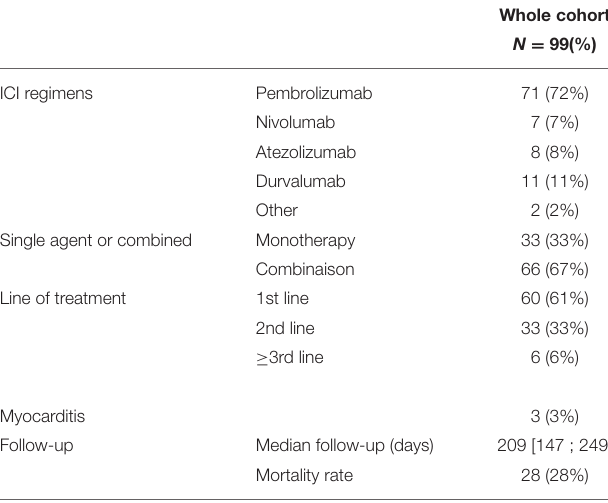
TABLE 1 | Patients’ characteristics at inclusion. TABLE 2 | Patients’